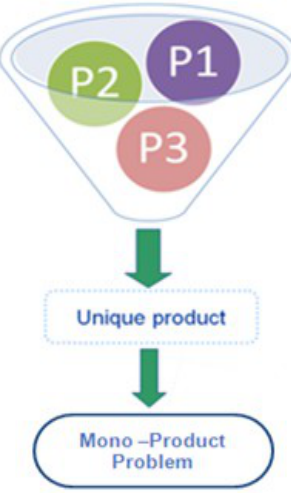
Figure 4. Scheme of Mono-product